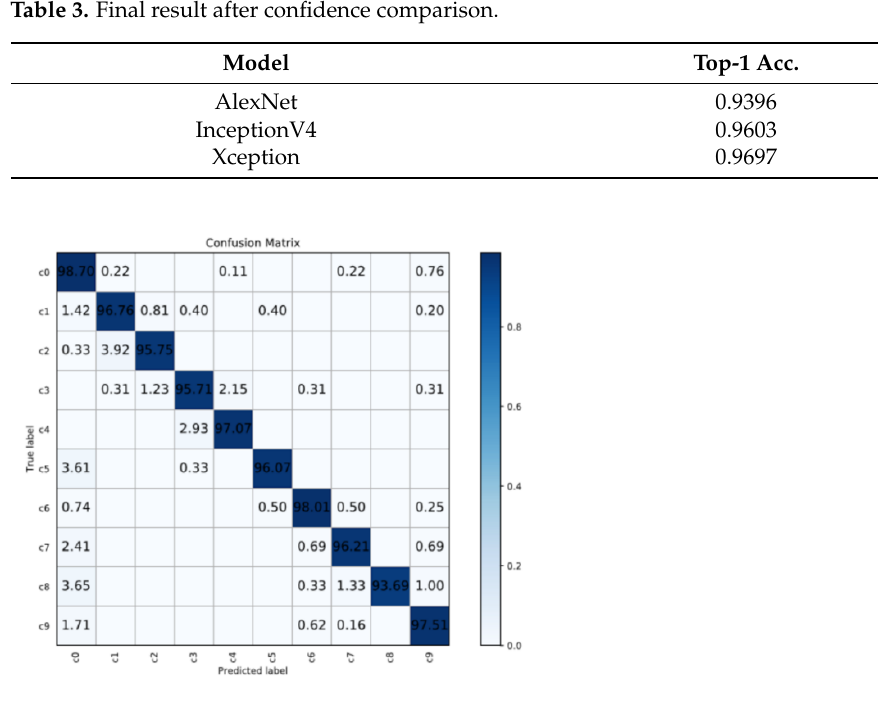
Figure 6. Confusion matrix of results Xception classification. Table 3. Final result after confidence comparison.